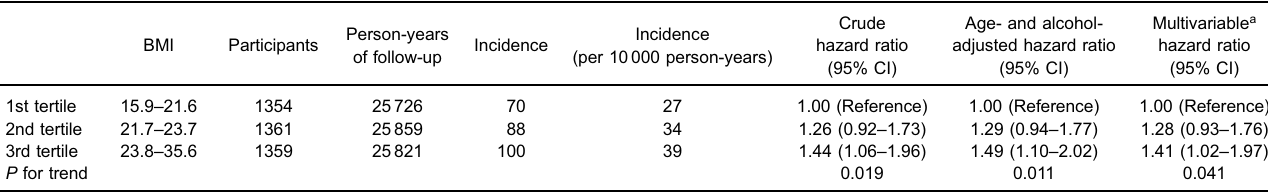
Table 3. Hazard ratios for incidence of kidney stones by BMI, 1985 to 2004 – 05 BMI